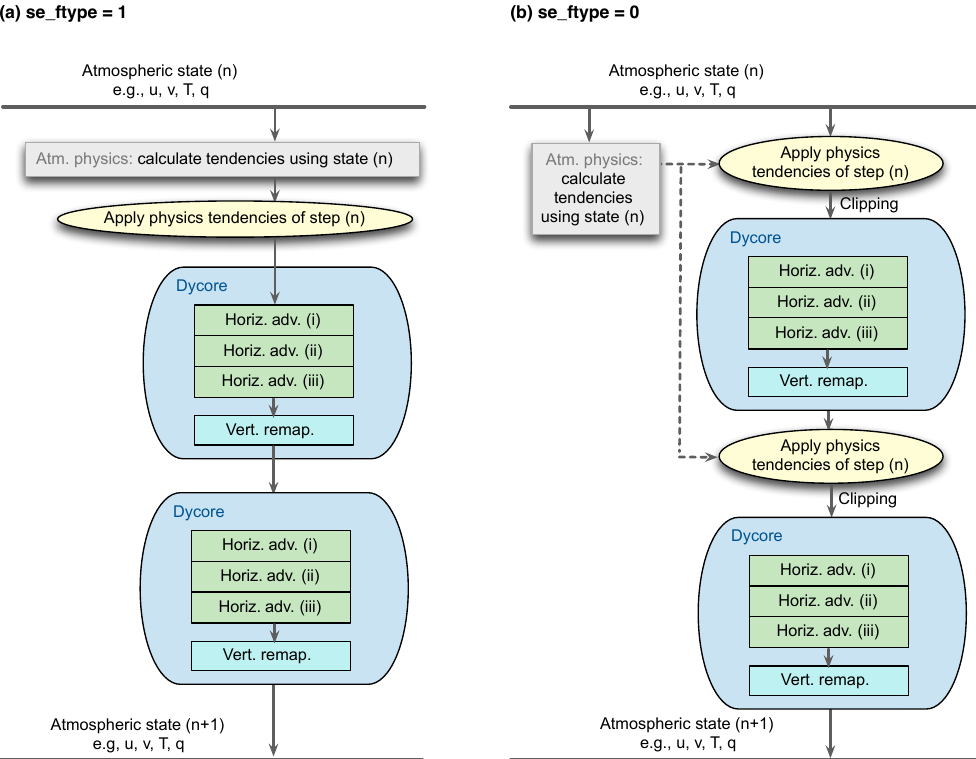
Figure 2. Diagrams showing two options for the coupling between parameterized physics and resolved dynamics in EAM. “Clipping” in (b) refers to the fact that negative water concentrations are reset to zero after the physics tendencies are applied. The examples shown here correspond to se_nsplit = 2 and se_rsplit = 3. Further details are explained in Sect.